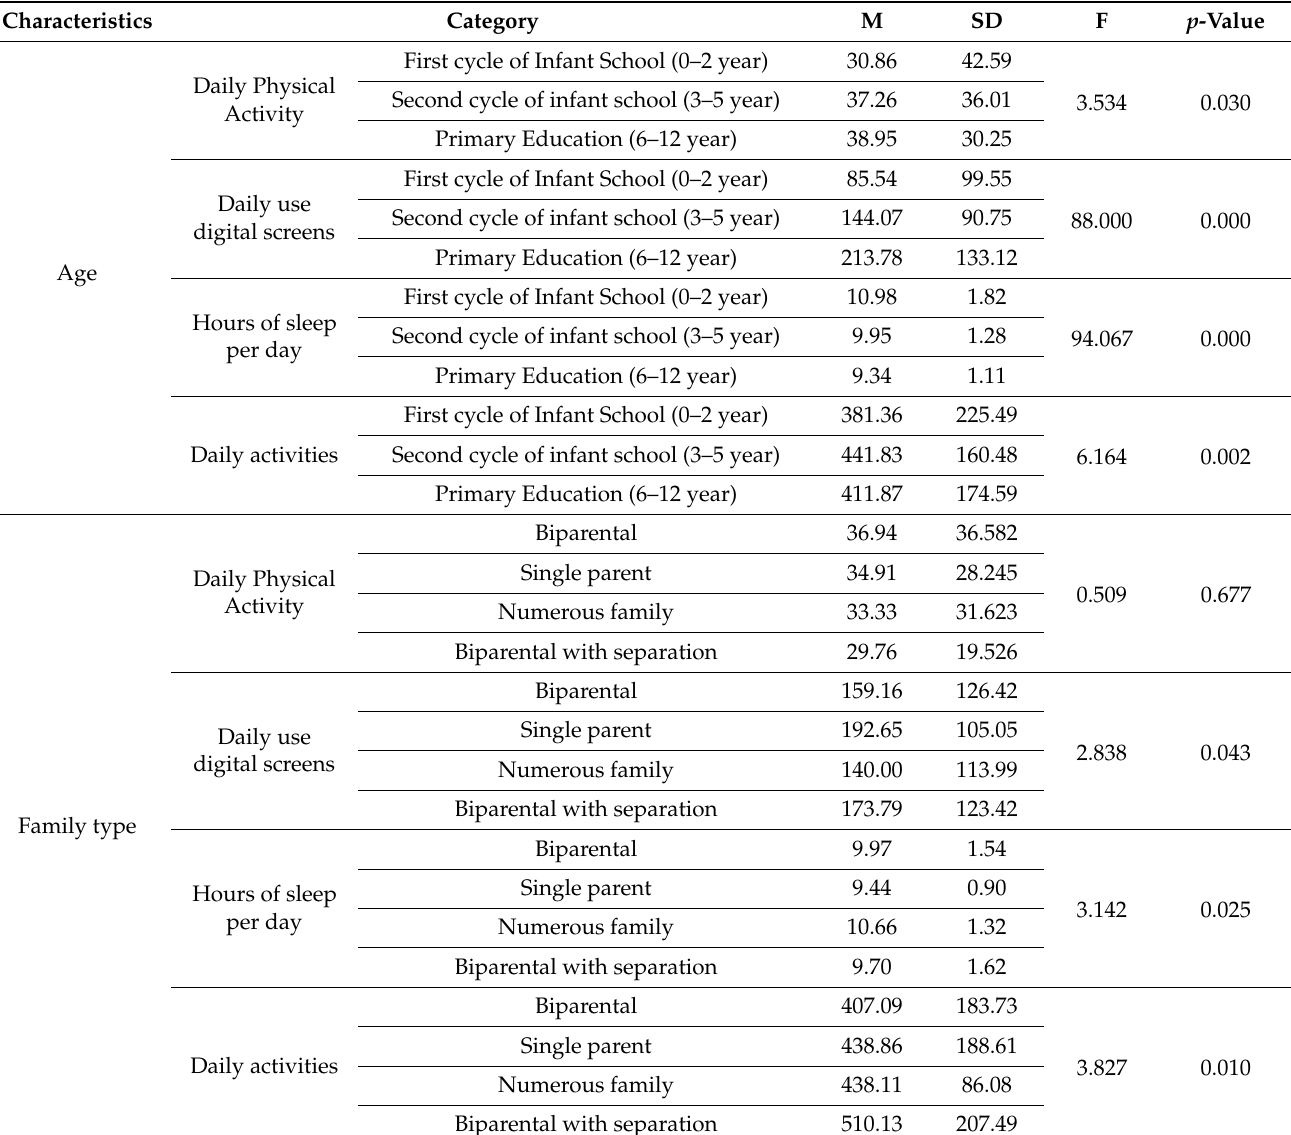
Table 4. Age and type of family according to children’s healthy and everyday behaviours.